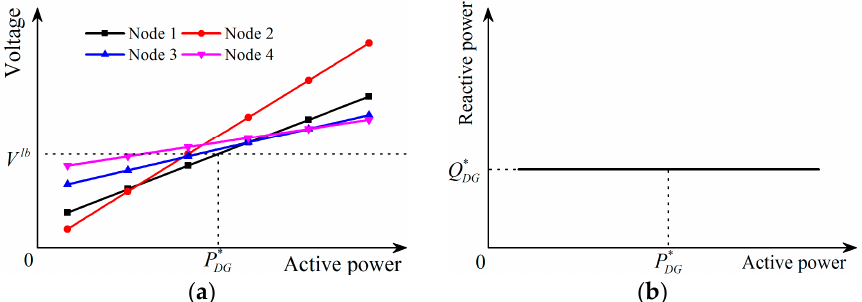
Figure 1. Voltage magnitude and reactive power variation according to active power: Fixed reactive power controller, ( a ) Voltage magnitude; ( b ) Reactive power.